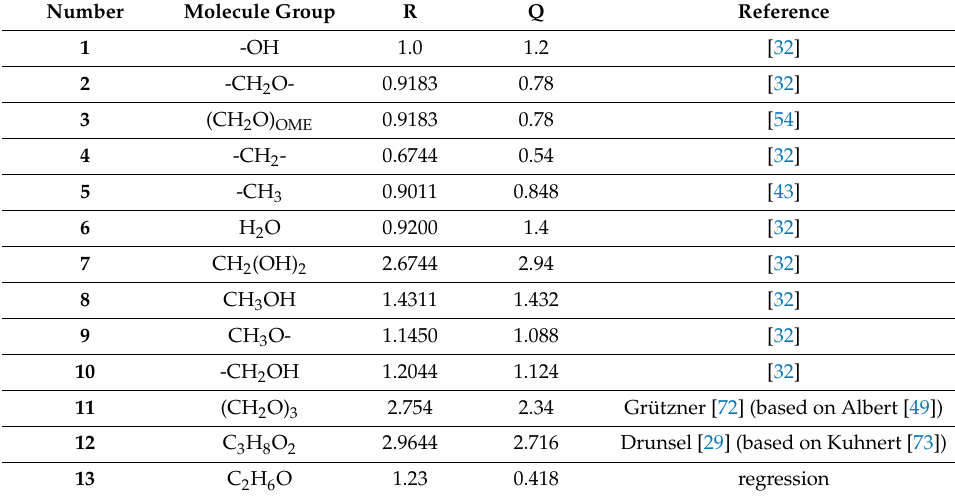
Table A3. UNIFAC volume and surface parameters.